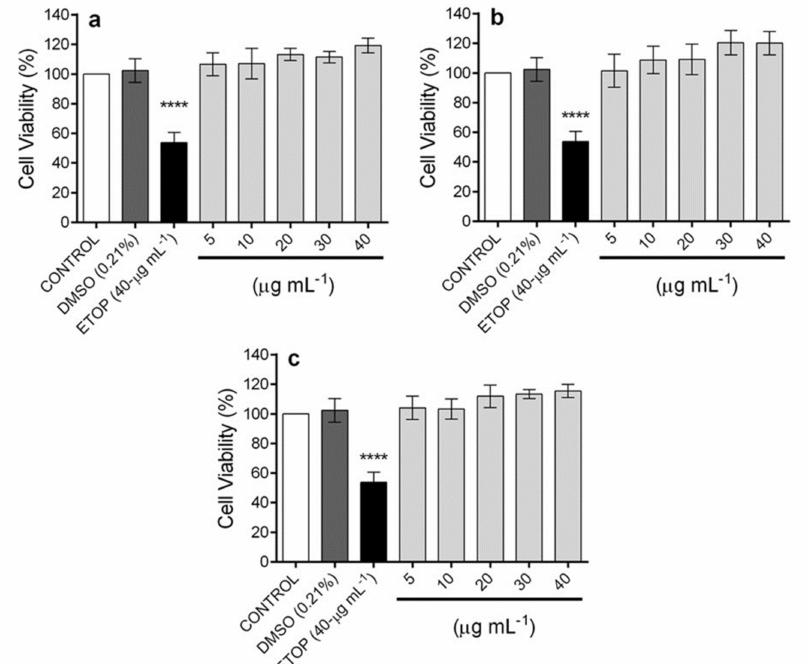
Figure 7. E ff ect of ethyl acetate extracts from A. pinchichensis cell suspension cultures on the viability of RAW 264.7 cells. ( a ) extract from day 8 (D8); ( b ) extract from day 12 (D12); ( c ) extract from day 16 (D16). The values are expressed as the mean ± SD of three independent experiments ( n = 3). Significance was determined using ANOVA, followed by Dunnett’s multiple comparisons test (**** p < 0.0001 dimethyl sulfoxide (DMSO), ETOP (etoposide), and extracts compared with the control